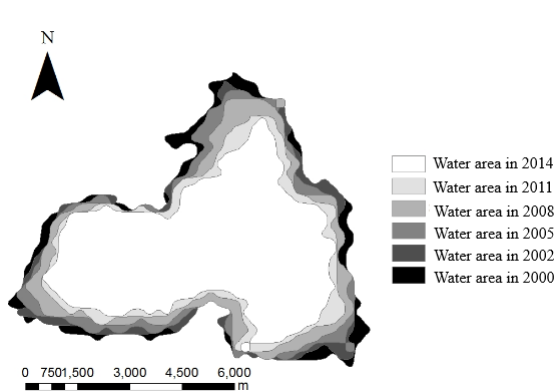
Figure 4. The schematic diagram of area reduced of Hong Jiannao